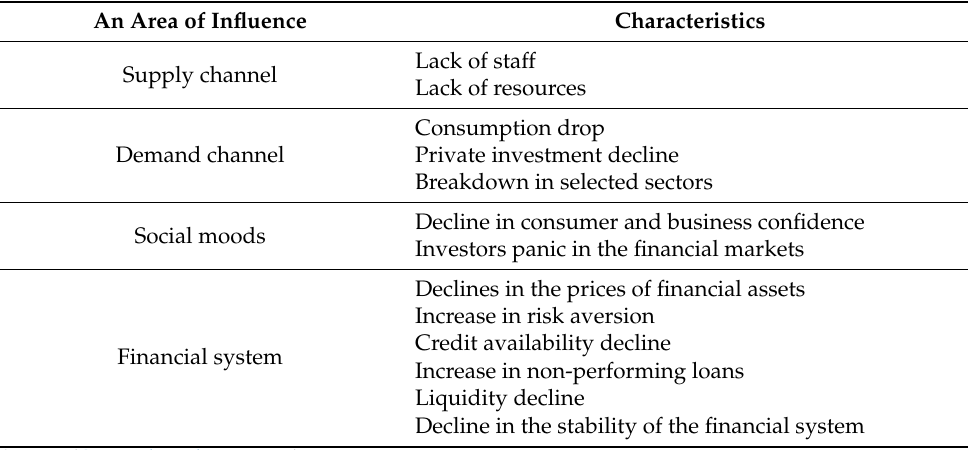
Table 2. Channels of impact of the COVID-19 crisis on the economy. An Area of Influence Characteristics Lack of staff Supply channel Lack of resources Consumption drop Demand channel Private investment decline Breakdown in selected sectors Decline in consumer and business confidence Social moods Investors panic in the financial markets Declines in the prices of financial assets Increase in risk aversion Credit availability decline Financial system Increase in non-performing loans Liquidity decline Decline in the stability of the financial system Source: (Grzeszak et al. 2020, p.